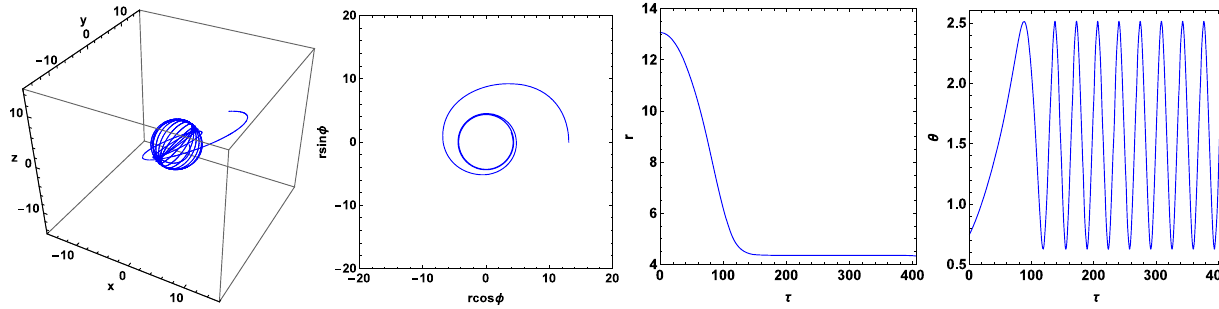
Fig. 1 The homoclinic orbit H3 in the Kerr spacetime in Ref. [65]. The system parameters are set to a = 0 . 2, E = 0 . 95303 and L = 2 . 05365 Fig. 2 The hyperbolic fixed point (red point) in Kerr spacetime (in the left panel) in Ref. [65] and the homoclinic tangles under the interaction with Chern–Simons invariant with α = 4 (in the right panel)